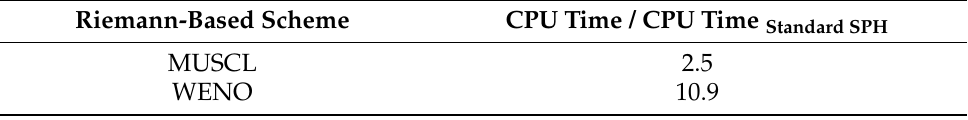
Table 1. Computational time of Riemann-based schemes relative to a standard SPH scheme (for a given